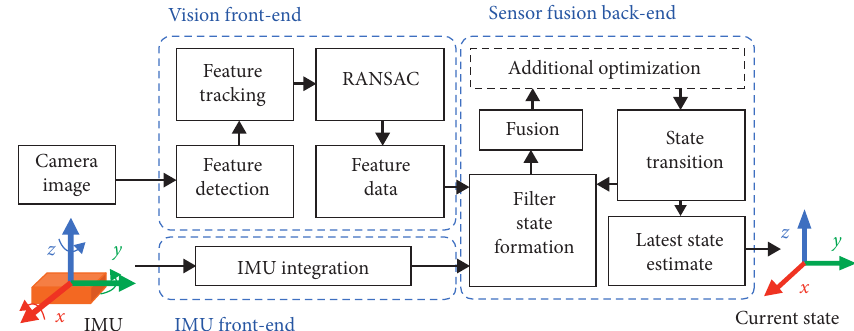
Figure 1: Overview of visual inertial odometry